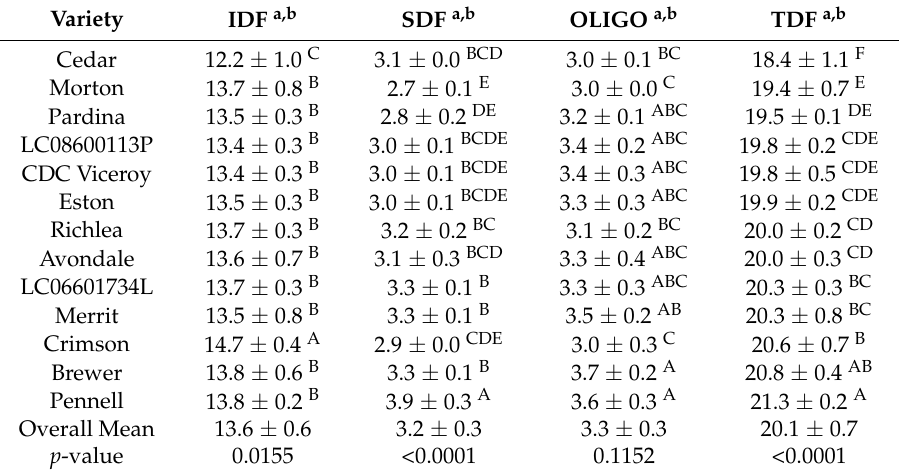
Table 4. Dietary fiber content of lentil cultivars and breeding lines.